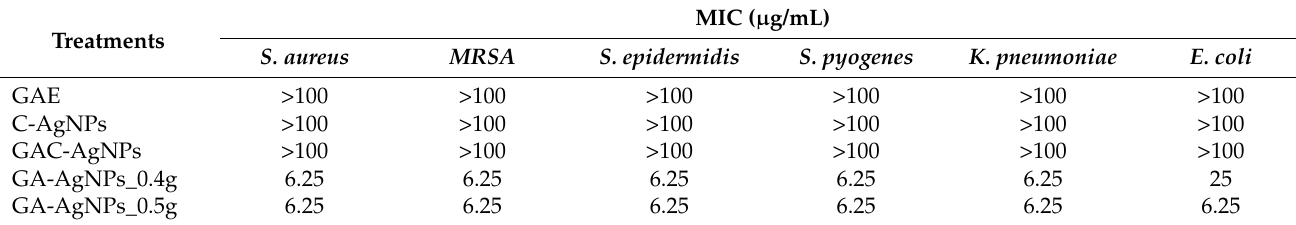
Table 4. MIC of the AgNPs on test